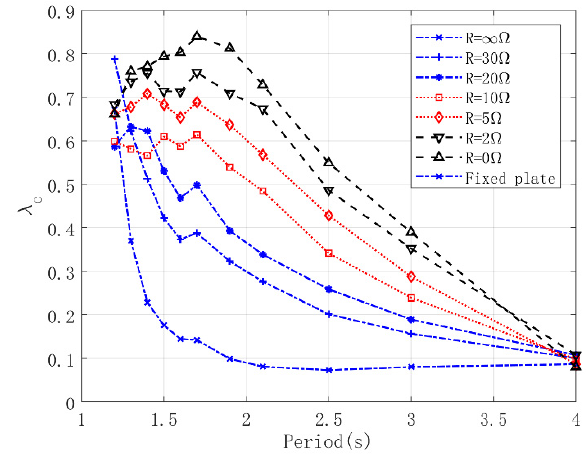
Figure 23. The captured energy ratio of THP1 with different tuned periods and LRs.